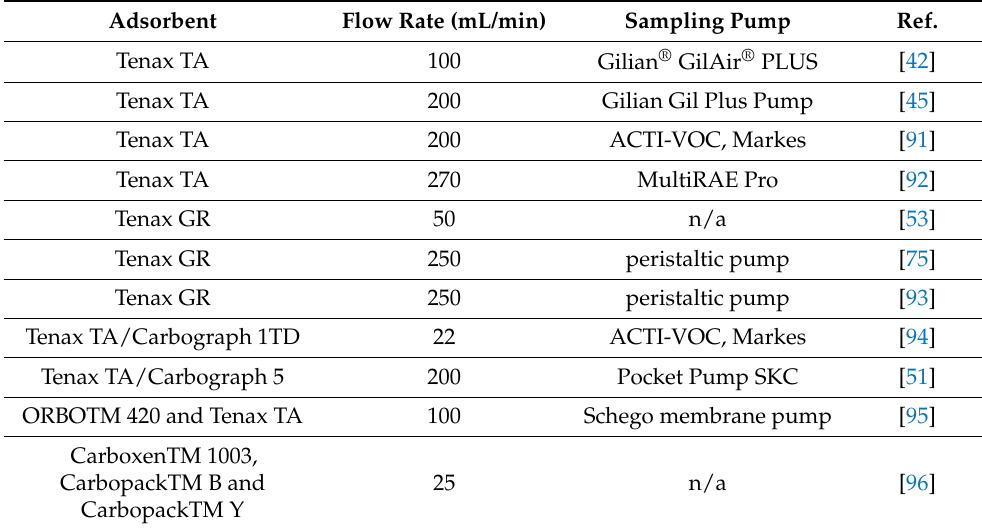
Table 6. Conditions of commonly used active sampling